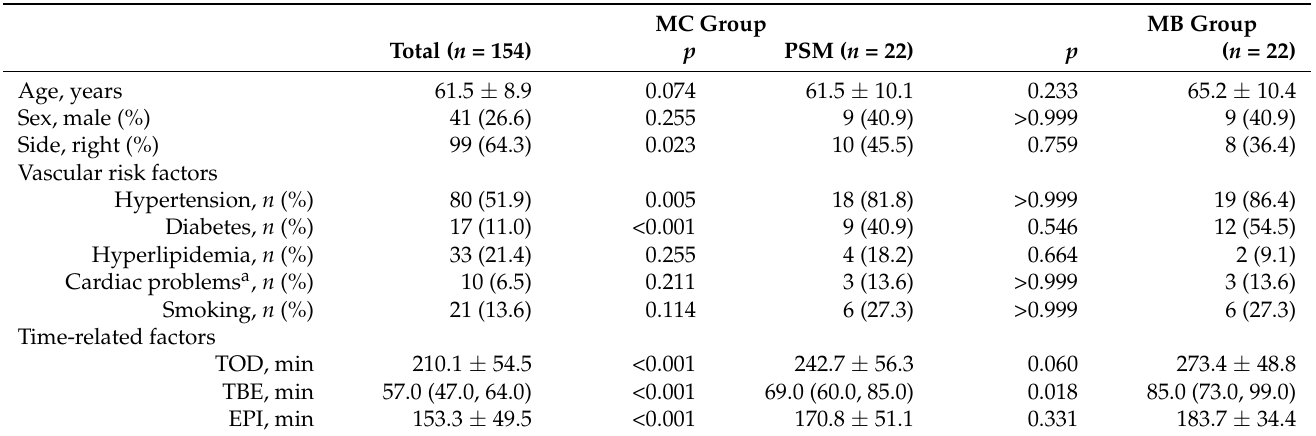
Table 1. Baseline characteristics of patients.